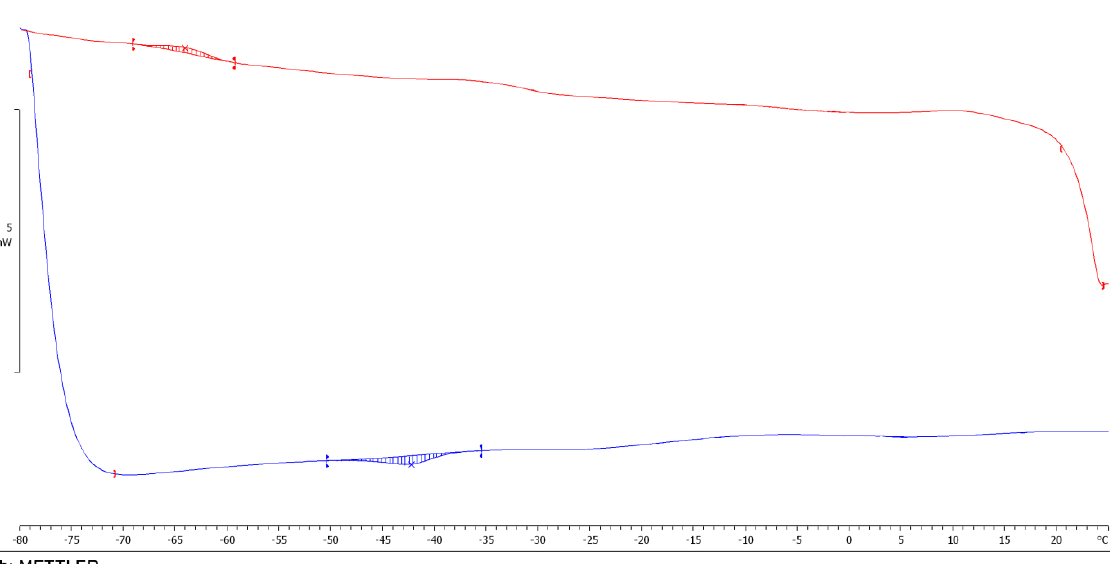
Figure 7. DSC curve of decyl butoxyethyl adipate. Figure 8. DSC curve of DOP. 3.6. Determination of the Melt Flow Rate To assess the rheological properties of plasticized PVC composites, we used such a parameter as the melt flow rate (MFR) of the polymer, which is widely used in practice to characterize the processability of polymer materials and select a processing method. The studies were carried out on an IIRT-AM device in the temperature range from 160 to 205 °C.